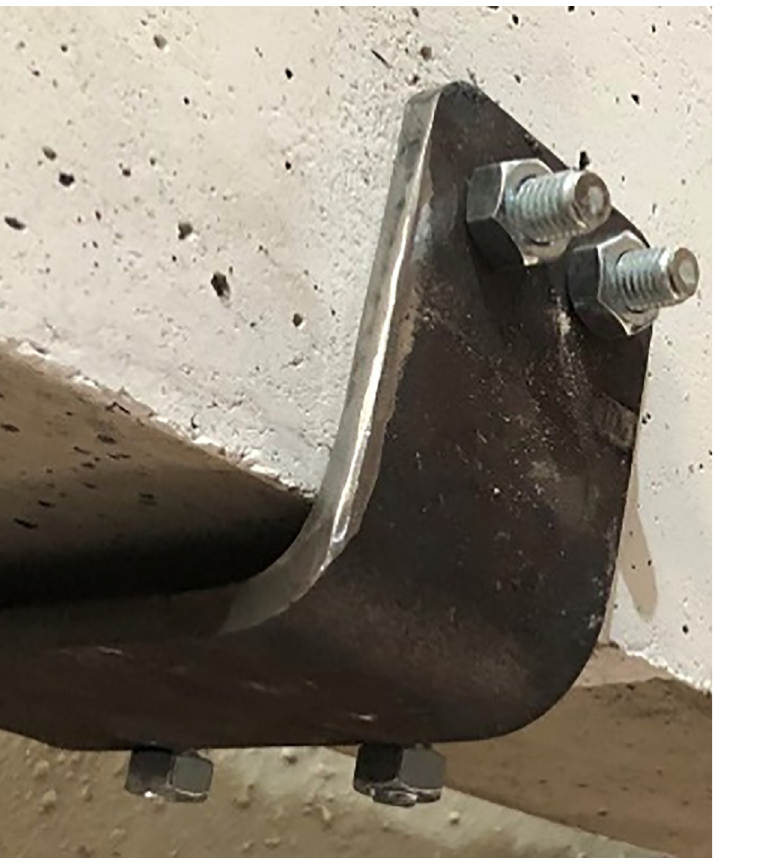
Fig 14. Fillet in the flanges of the channel.